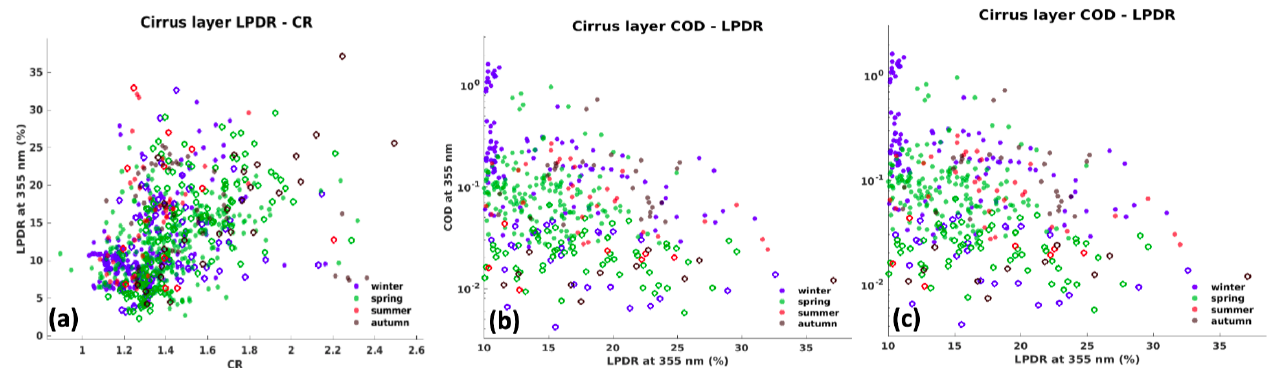
Figure A1. Inter-relation of cirrus optical properties on a seasonal basis. Cirrus layer LPDR-CR ( a ), cirrus layer COD-LPDR ( b ) and cirrus layer COD-LPDR ( c ).